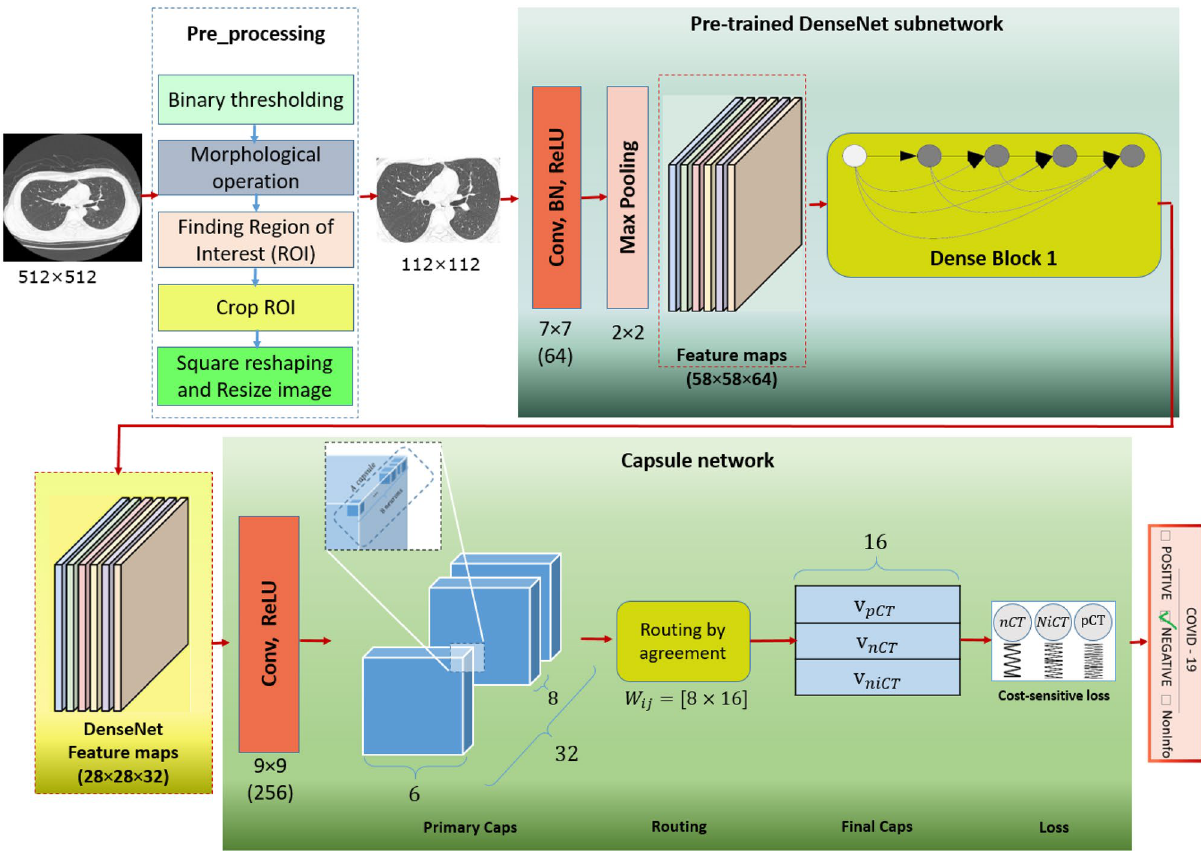
Figure 1. Our regularized cost-sensitive CapsNet combined with DenseNet (RegCS.CapsDensNet) overall architecture. CT image is first preprocessed and then feed into our deep network, where its crucial features are extracted by DenseNet conjugating with CapsNet. The cost-sensitive regularized loss function is considered in the capsule network to overcome imbalanced